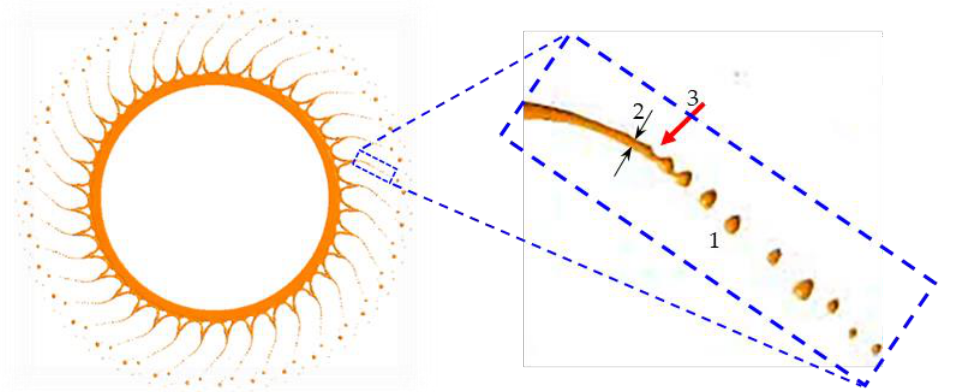
Figure 5. Breakup process of a single molten slag ligament. 1: Enlargement of one ligament; 2: Meas- u r ement position of ligament diameter ( d l ); 3: Neck region of ligament.